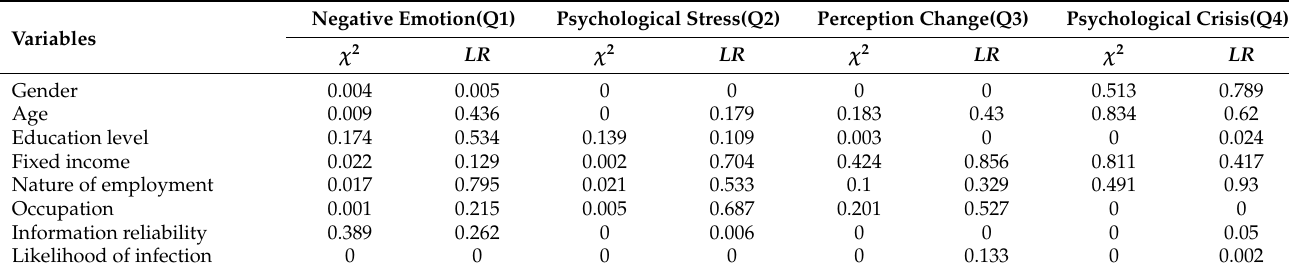
Table 3. Correlation between psychological status and influencing